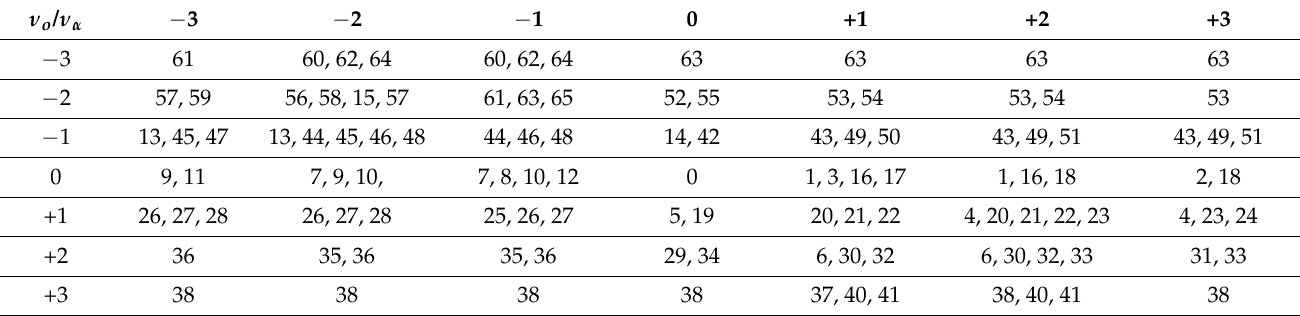
Table 2. Look-up table associated with the α o coordinates.